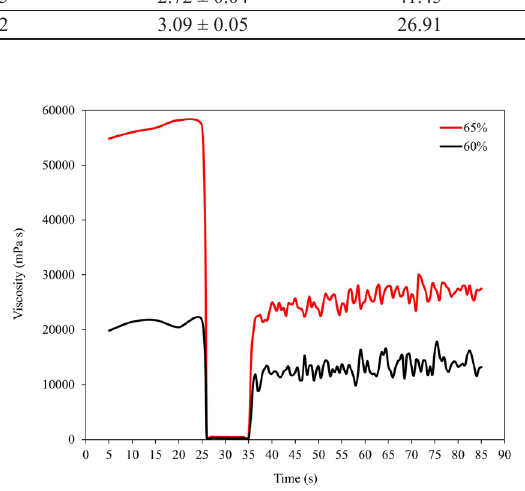
Figure 13. Time-dependent behavior for the 65/1 and 60/1 composition slurries obtained after homogenization in vibrating mill for 20